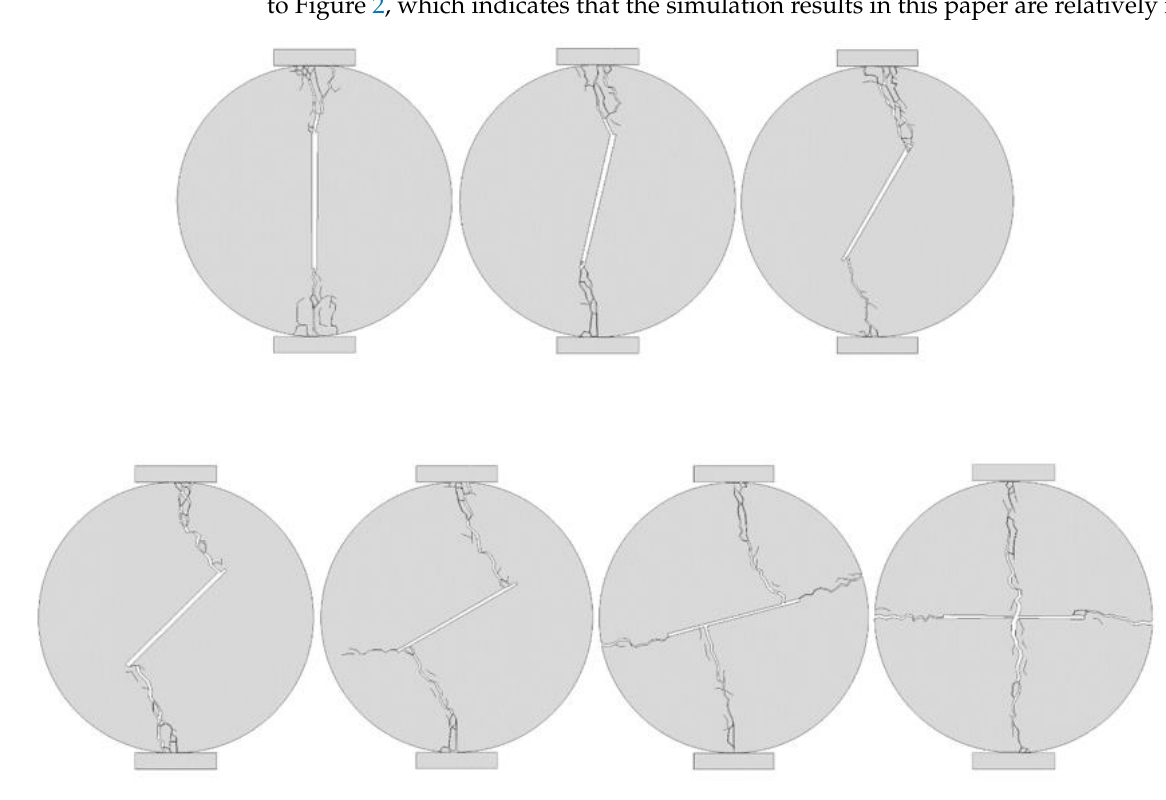
Figure 24. The failure mode transition for Brazilian discs with cracks of different angles.